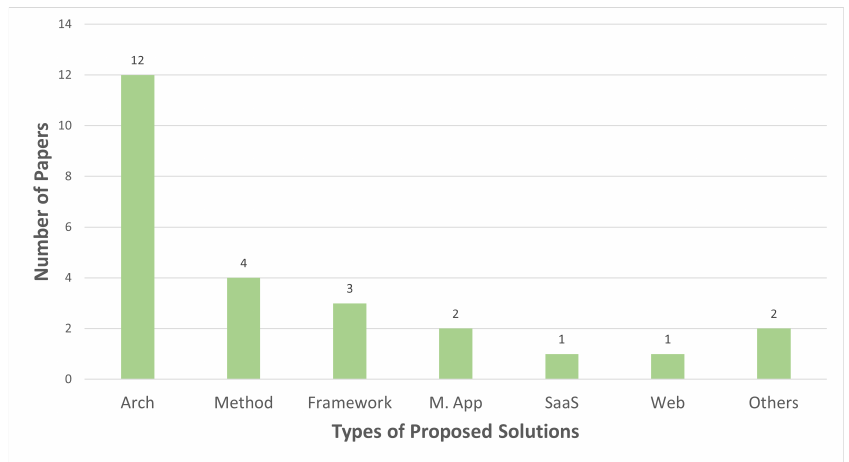
Figure 5. Types of MCS-aided disaster management solutions. Arch: System Architecture; M.Ap: Mobile Application; SaaS: Software as a Service; Web: Web Application.